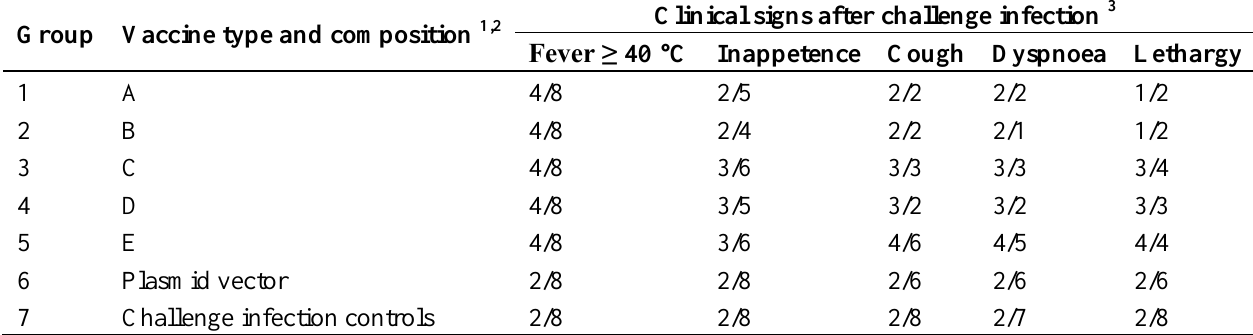
Table 2. Clinical response of pigs immunised with experimental PRRS DNA vaccines and challenge infected with virulent